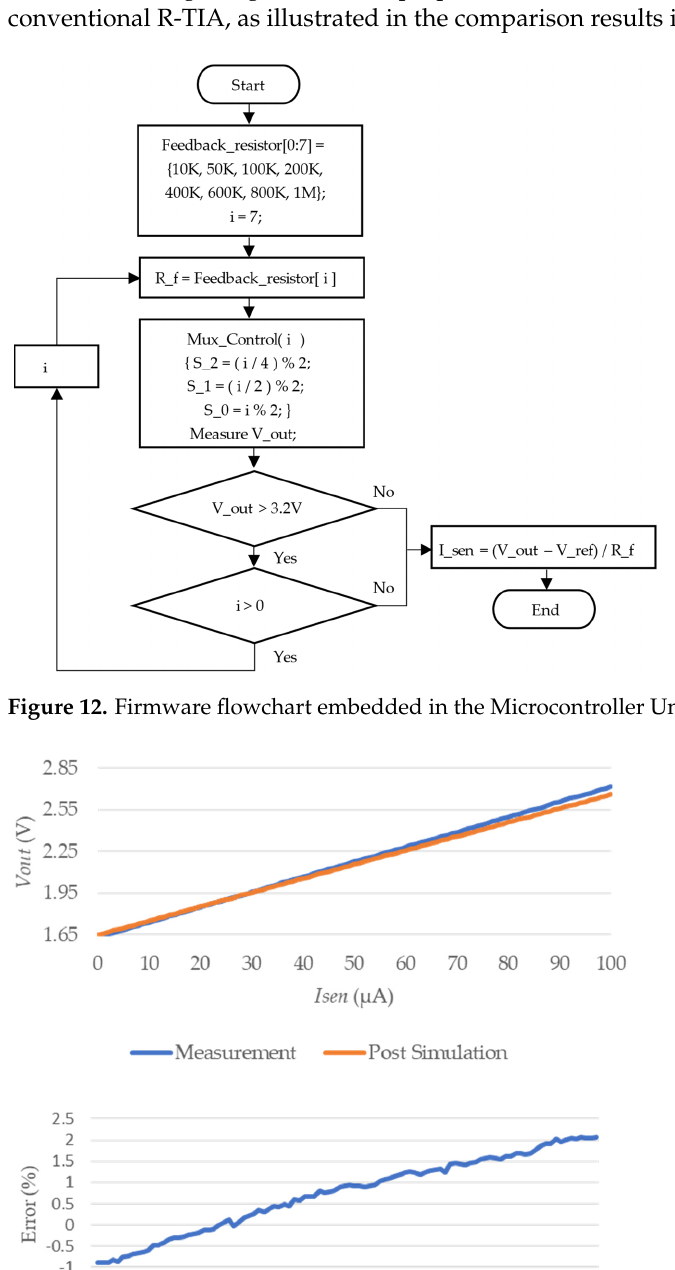
Figure 11. Block diagram of the experimental test setup.